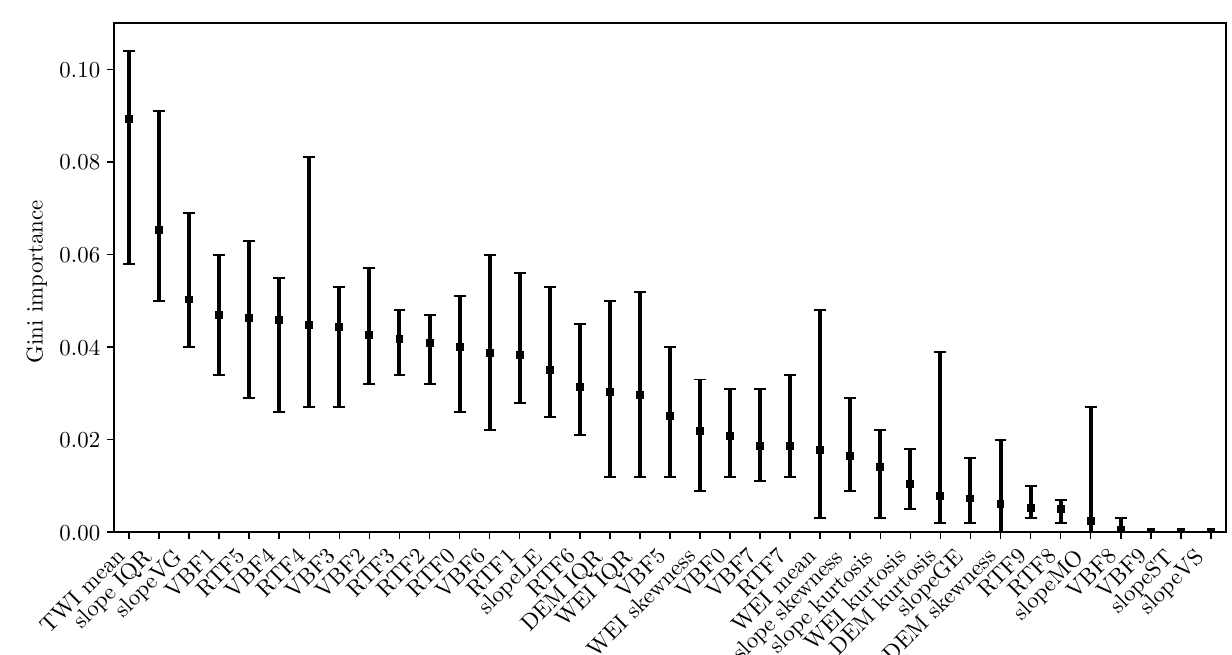
Figure 6. Gini importance for the 37 features (see Tables 1 and 2). Squares denote the mean importance, while errorbars show minimum and maximum importance for runs of different tile size and overlap.